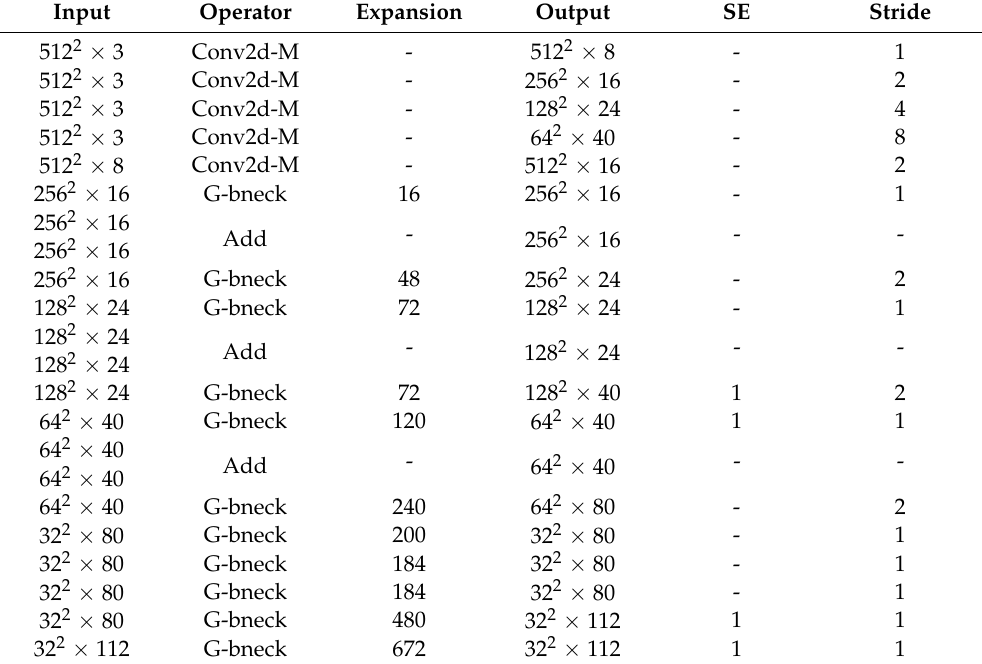
Table 1. Encoder structure network parameters.